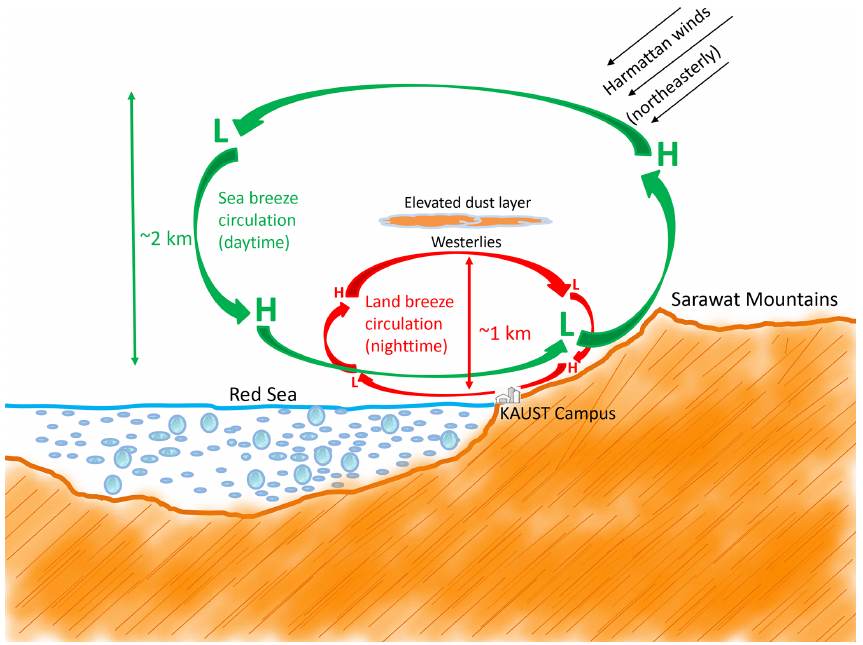
Figure 18. Schematic diagram showing sea breeze (daytime, in green) and land breeze (nighttime, in red) circulations and dust distribution over the study site at